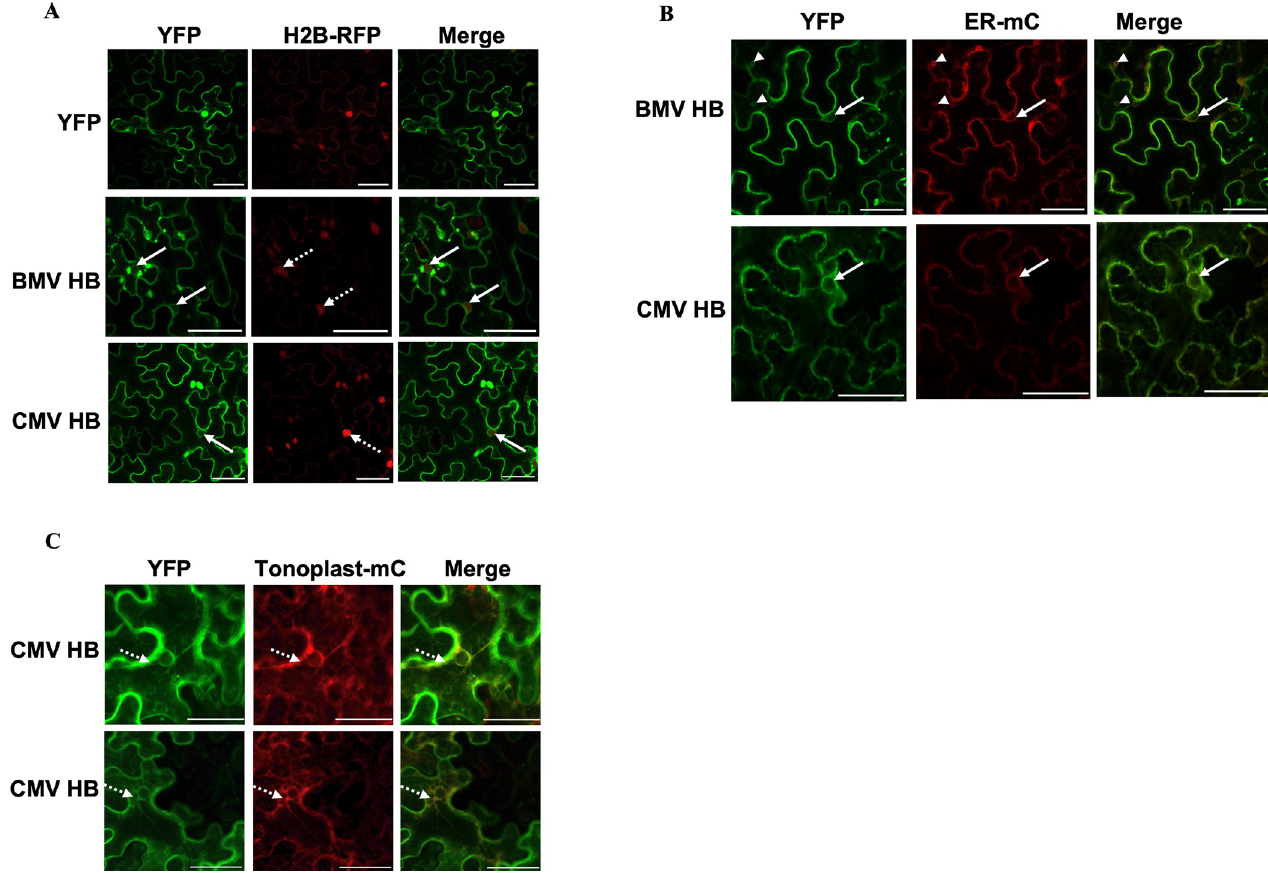
Fig 5. Localizations of BMV and CMV helix B in Nicotiana benthamiana cells parallel those in yeast cells. (A) YFP-tagged helix B from BMV or CMV was expressed in histone 2B-RFP transgenic N . benthamiana plants via agroinfiltration. Solid and dotted arrows point to the nER membrane and the nucleus, respectively. (B) BMV or CMV HB-YFP was co-expressed with an mC-tagged ER marker. Arrows point to the nER membrane and arrowheads point to small vesicles that are colocalized with the ER marker. (C) Colocalization of CMV HB-YFP with an mC-tagged tonoplast marker as indicated by dotted arrows. The fluorescence signal was observed under laser confocal microscopy at 40 hpai. Scale bars: 50 μ